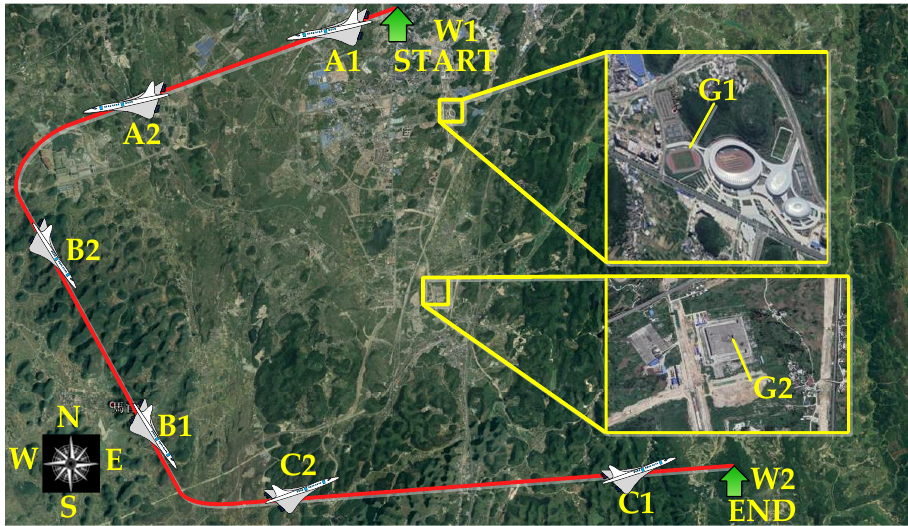
Figure 15. The flight path in Google Earth.